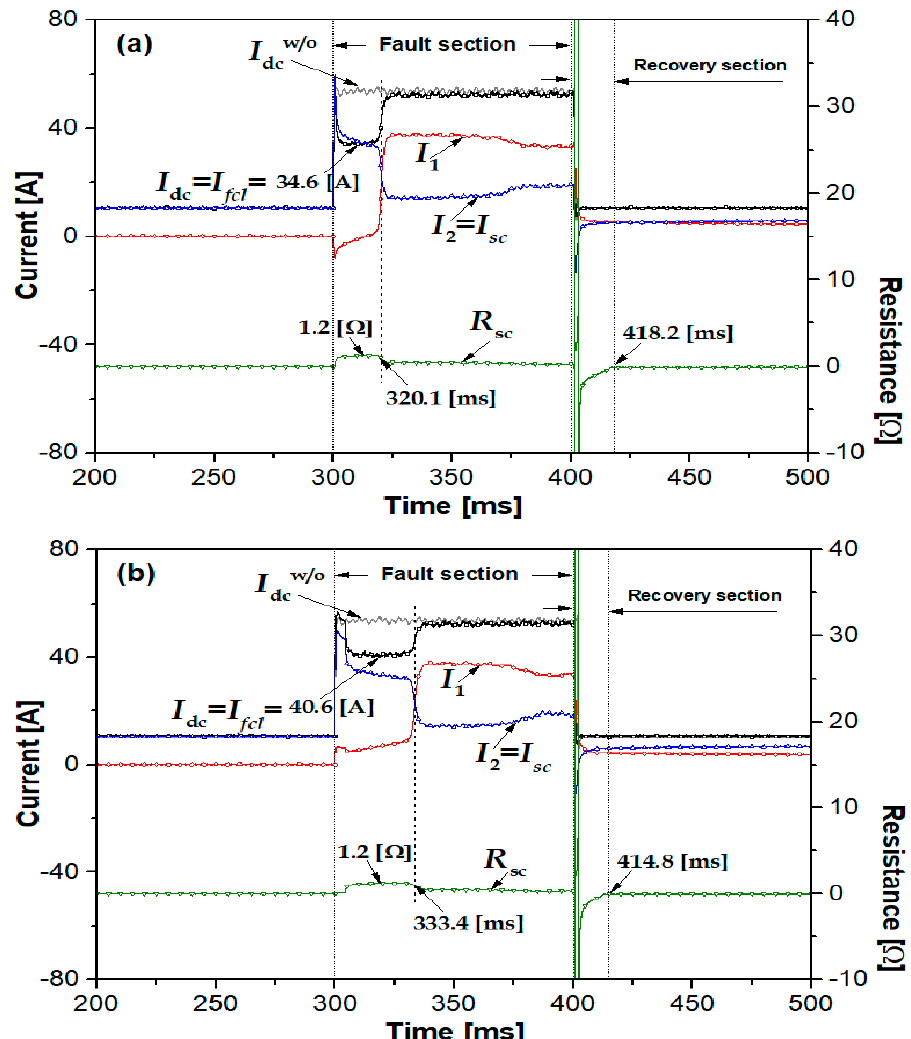
Figure 6. Current and SE resistance relationship of the flux-coupled type SFCL in accordance the wiring direction: ( a ) for the additive wiring; ( b ) for the subtractive wiring.